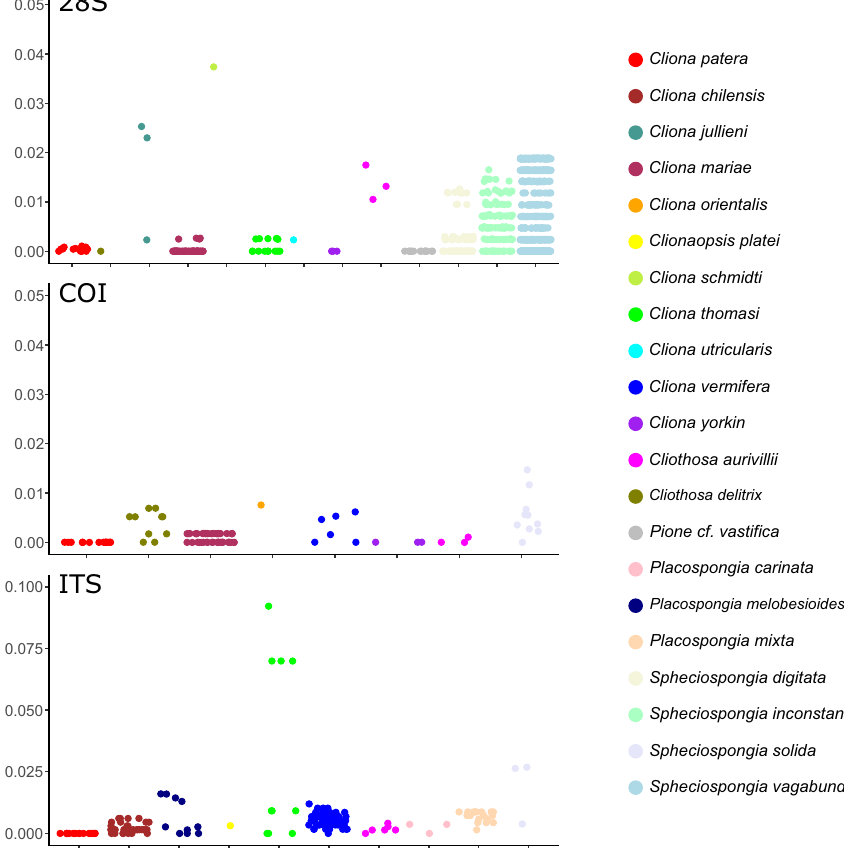
Figure 4. Intraspecific pairwise distances of clionaid species for three genes: nuclear 28S rRNA (top); mitochondrial cytochrome c oxidase subunit I (COI; middle), and nuclear internal transcribed spacers (ITS;